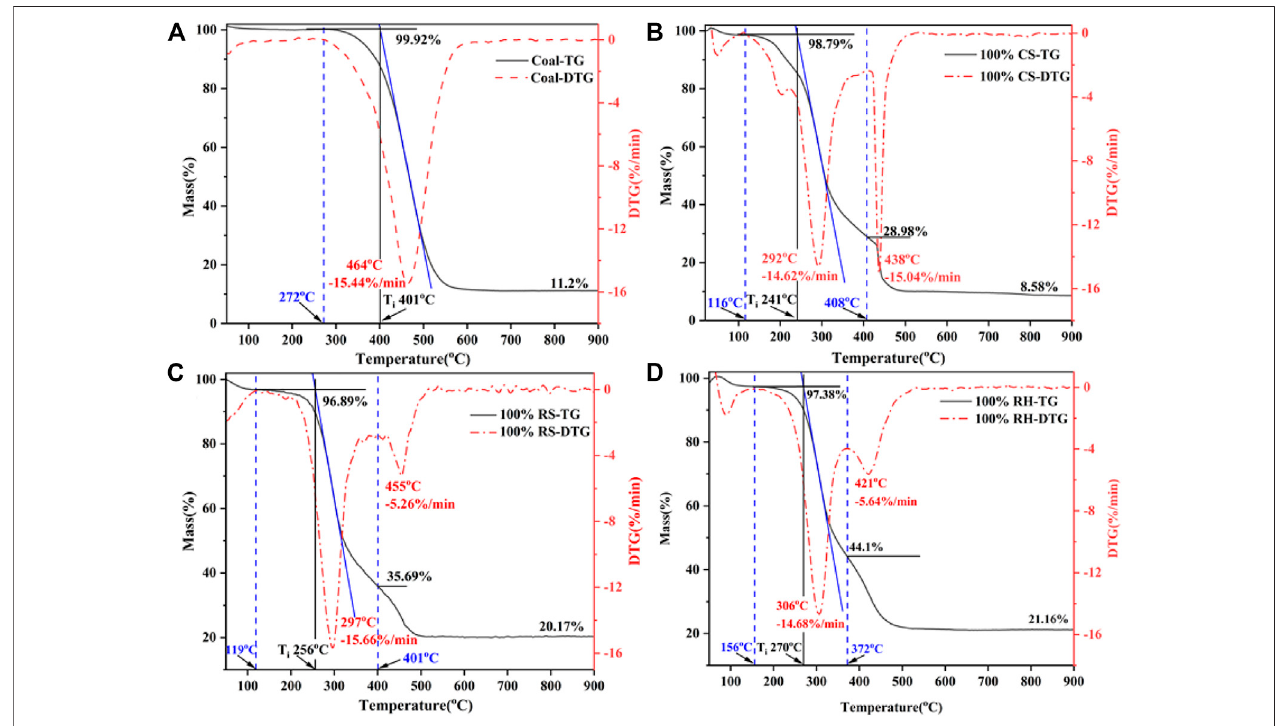
FIGURE 2 | Schematic diagrams of mass loss, stage division, and ignition temperature determination.